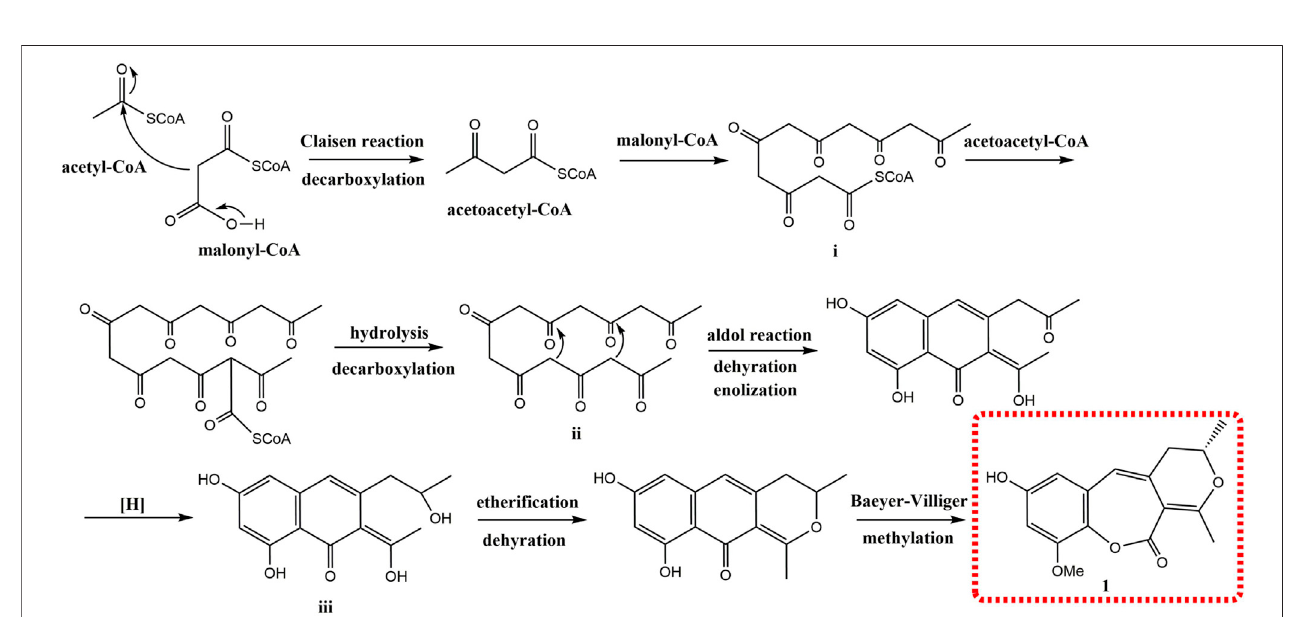
SCHEME 1 | Plausible biosynthetic pathway for 1